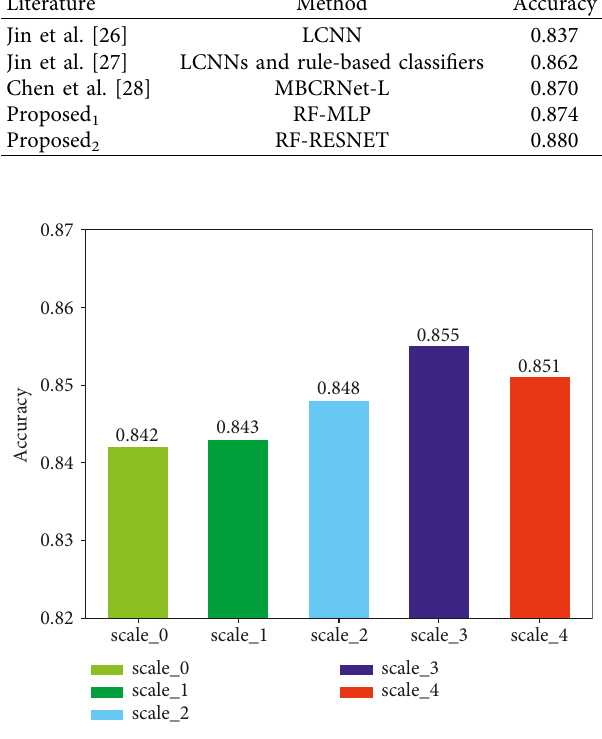
Figure 7: Classification results with different